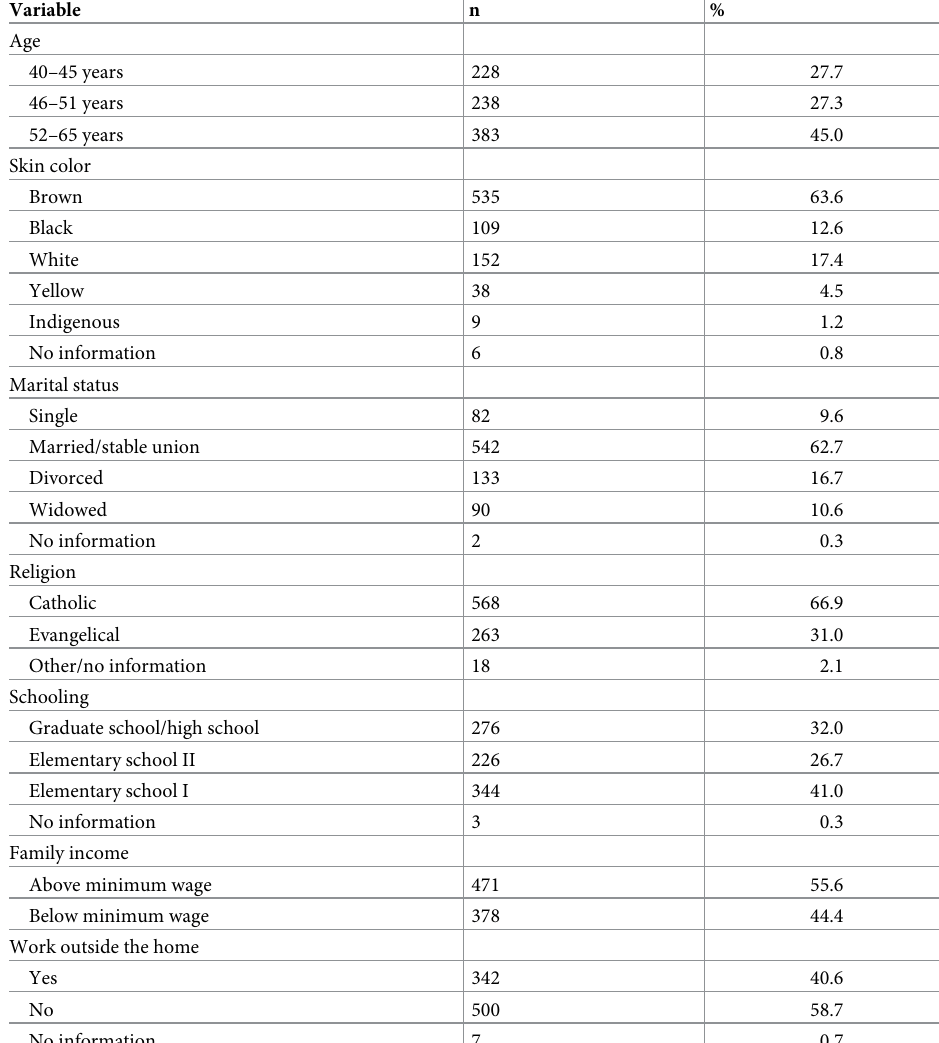
Table 1. Demographic and socioeconomic characteristics of climacteric women assisted by primary health care,